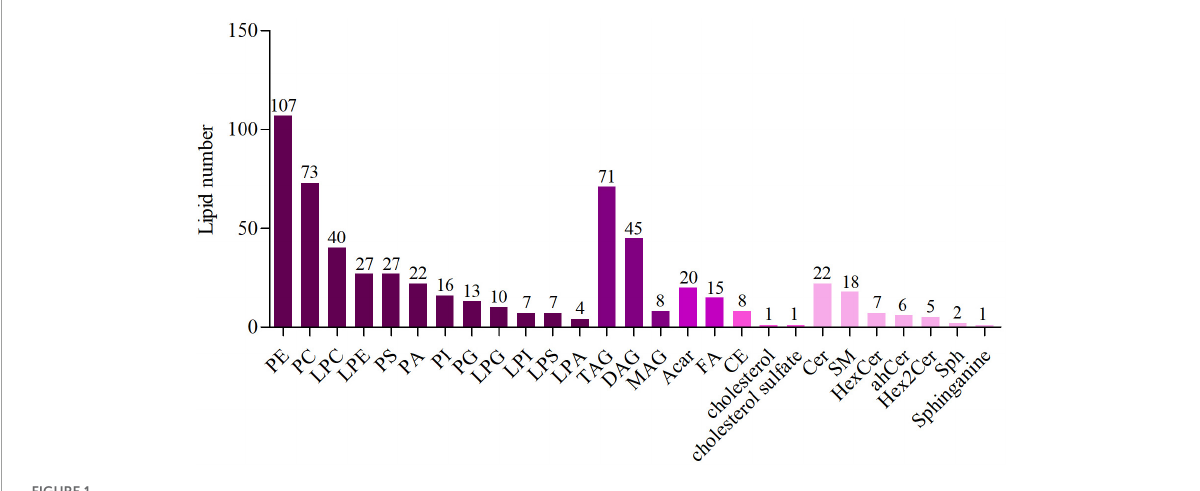
FIGURE1 The number of lipid species in lipid classes. Different colors represent different lipid classes and the numbers represent the number of lipid